Question: Describe this figure in one sentence.
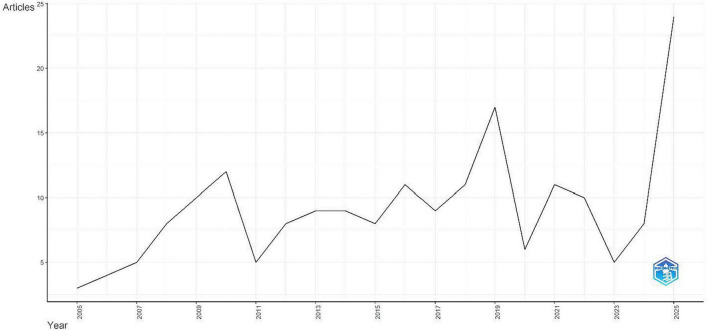
Answer: Annual scientific production. Line graph demonstrating the annual number of publications on faculty development needs assessment in medical education from 2005 to 2025, showing a marked increase after 2018.